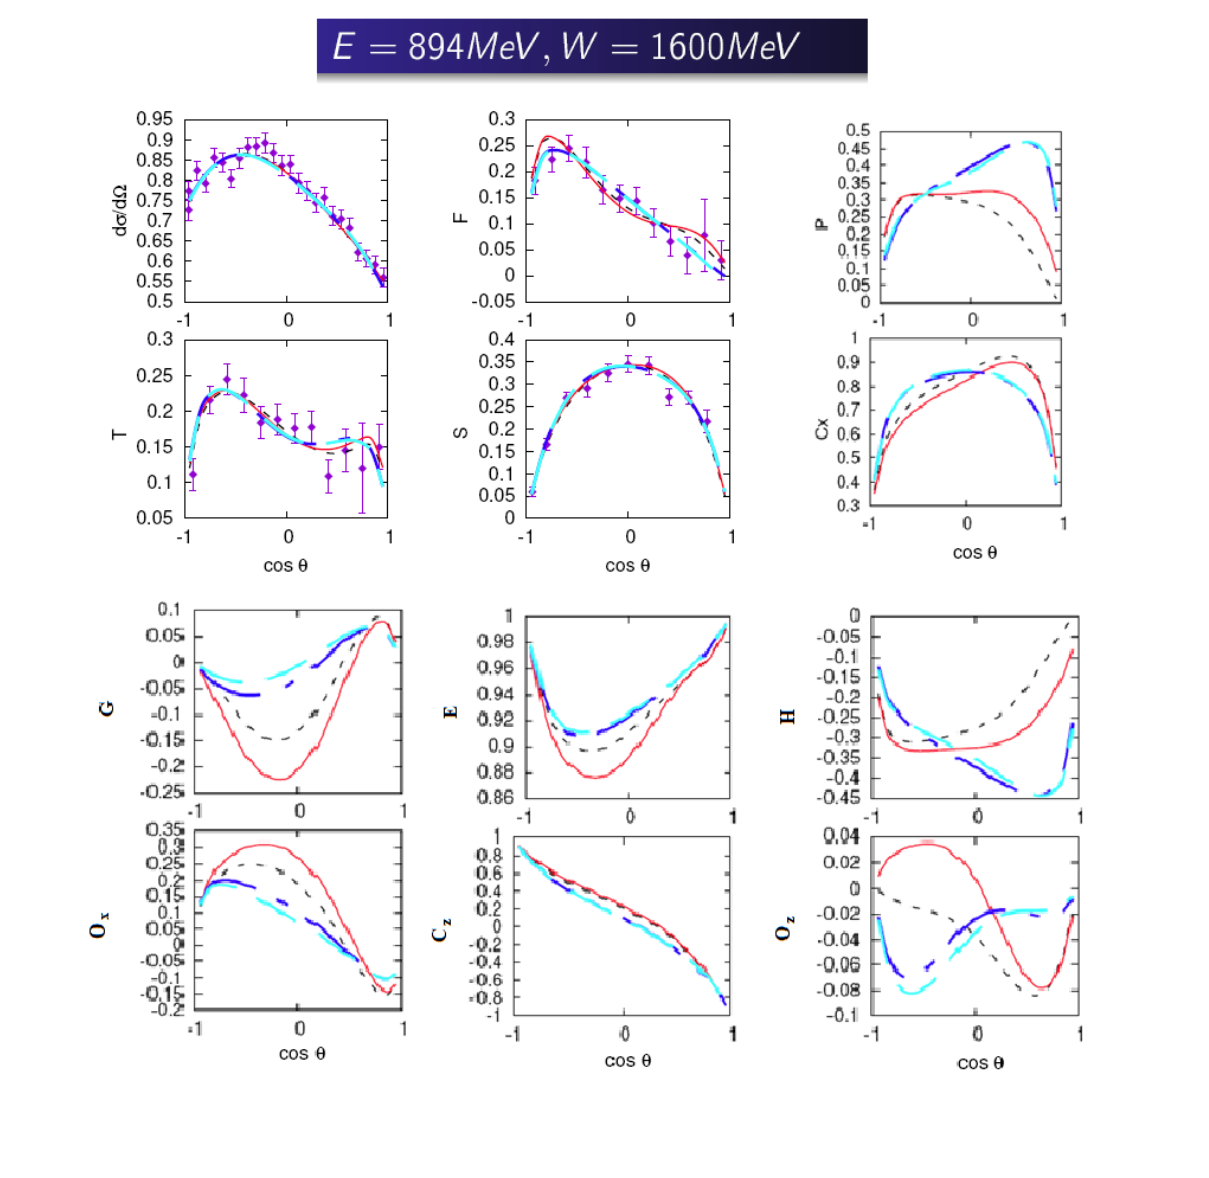
Figure 7: (Color online) The comparison of four obtained SE solutions with measured and unmeasured observables. The colors of the curves shown here correspond to the colors of the single-energy multipoles shown in Figs 5 and